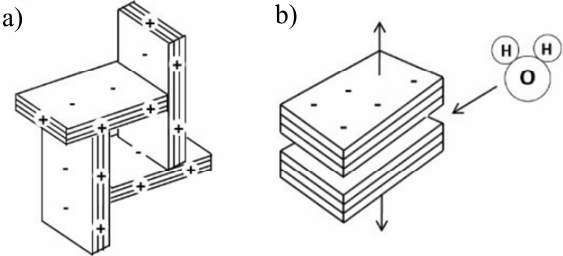
Figure 1. Bentonite B in contact with an aqueous solution of HNO 3 ; ( a ) pH = 3; ( b ) pH = 5. All the vials contain bentonite B.